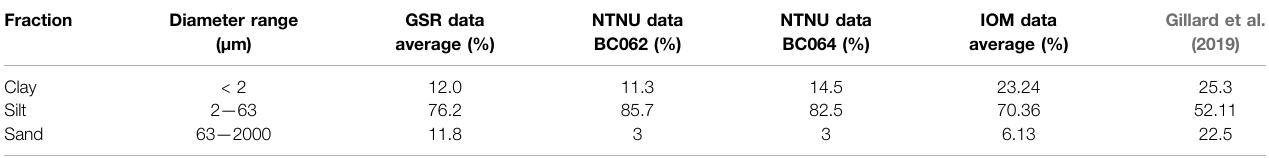
TABLE 2 | Fraction distribution of sediments. GSR and NTNU data from (Lang et al., 2019), IOM data from (Zawadzki et al., 2020). Averaged data is provided by Global Sea Resources, based on the Belgium license area in the CCFZ, NTNU data is data of speci fi c box-cores of the GSR data average. IOM data is based on data of the Inter Ocean Metal license area in the CCFZ.